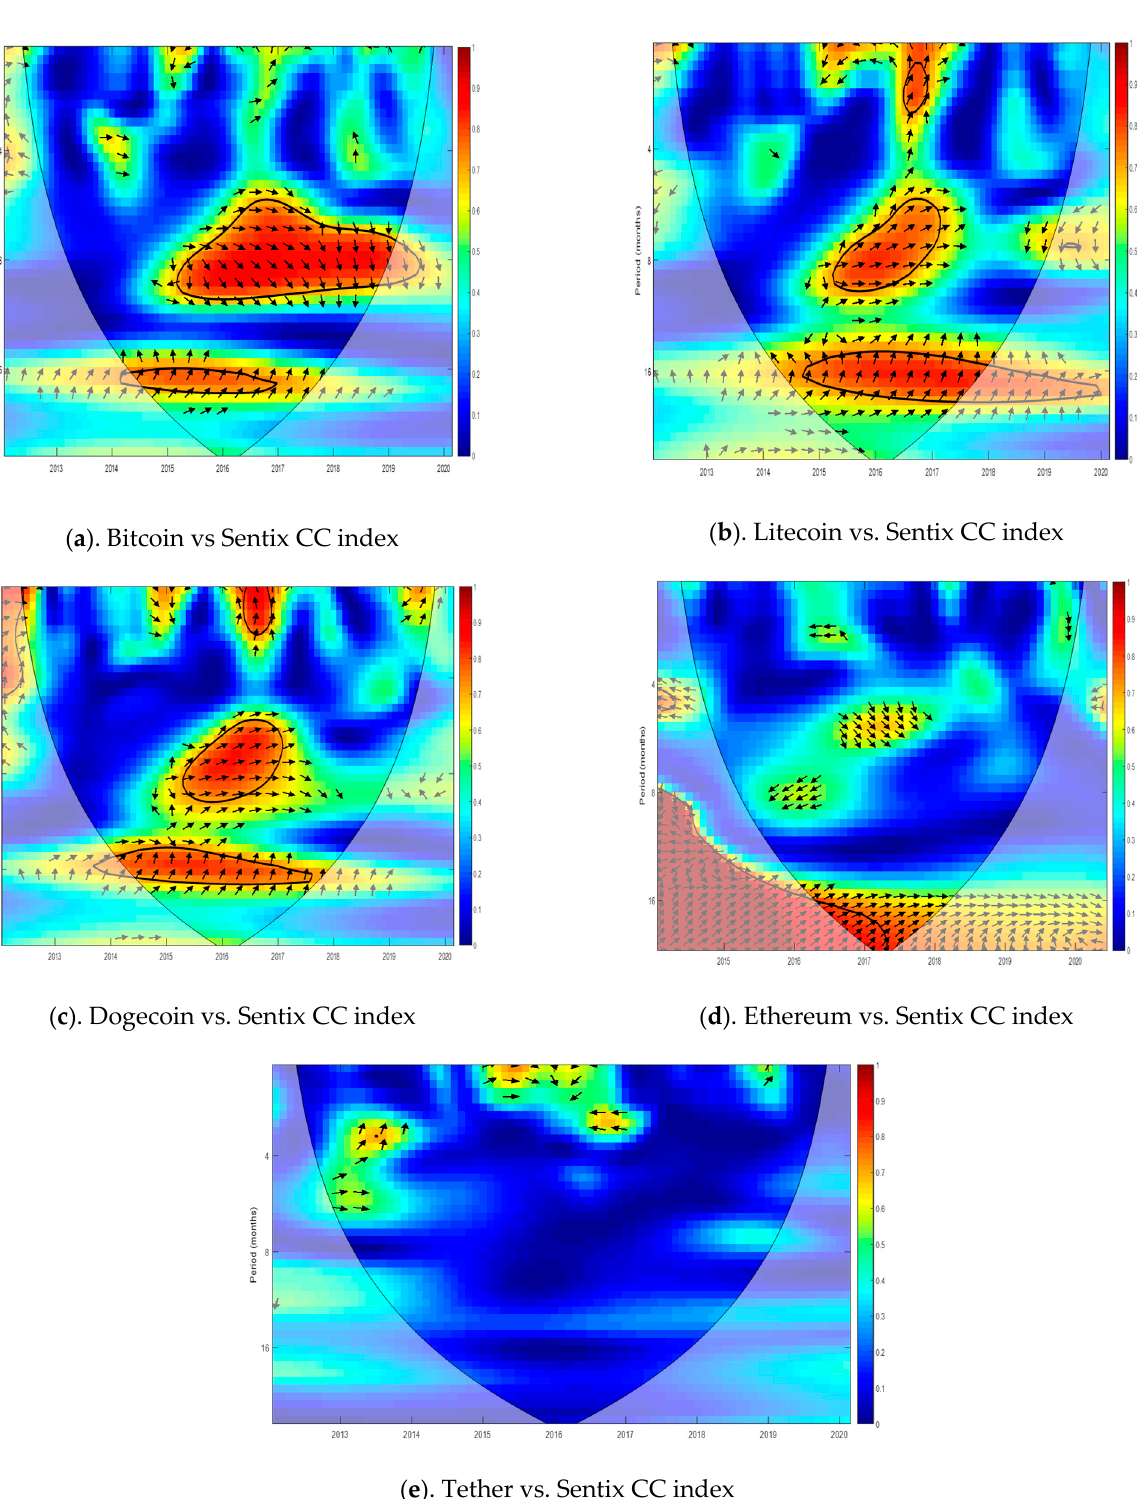
Figure 2. Wavelet coherencies between cryptocurrencies prices and Sentix Cryptocurrency index. The black contour identifies the regions in which the spectrum is significant at the 5% level against red noise. The cone of influence (COI) is specified by the lighter shade, which delimits the high-power regions. The horizontal and vertical axes denote time and scale bands, respectively.